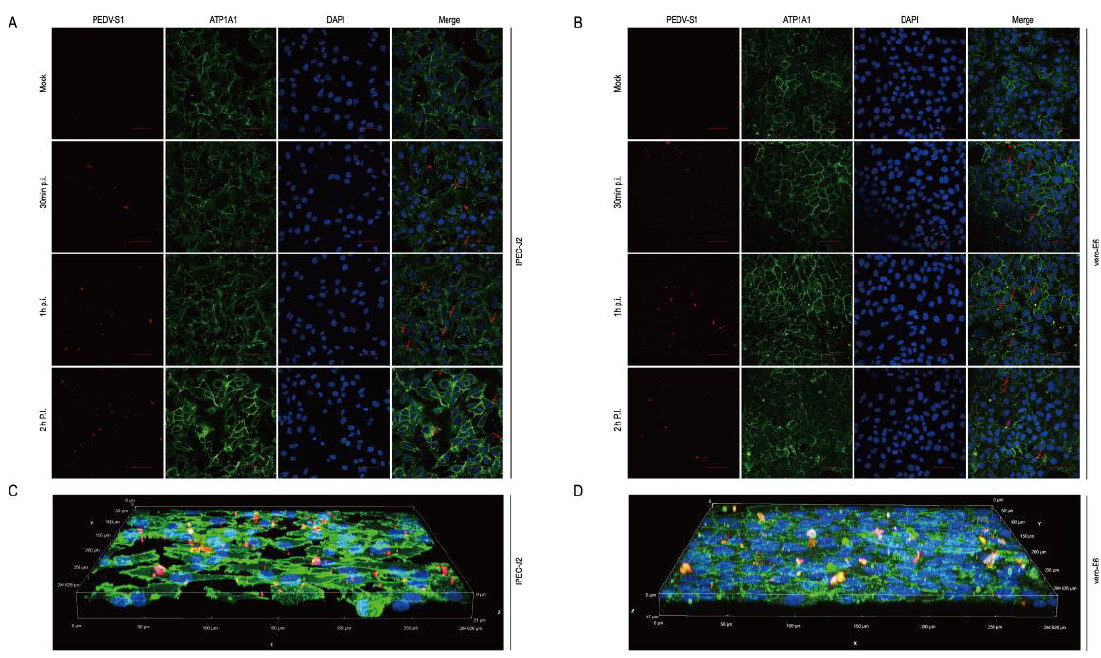
Figure 8. The host protein ATP1A1 co-localizes with the PEDV S1 protein early in PEDV infection. ( A , B ) ATP1A1 co-localized with the S1 protein. PEDV at 0.1 MOI infected with IPEC-J2 and Vero-E6 to the specified time. Cells were then stained with antibodies corresponding to Figure 7B. The nuclei were stained with DAPI (blue). The red arrows indicate co-localized signals (scale bar = 50 μm). ( C , D ) 3D Rendered Image. PEDV at 0.1 MOI infected IPEC-J2 and Vero-E6 cells for 1 h; cells were stained with the antibodies, with the antibody corresponding to Figure 7B. Staining of cell nuclei using DAPI (blue) staining solution. The panel shows a three-dimensional rendering; the red arrows indicate co-localized signals.